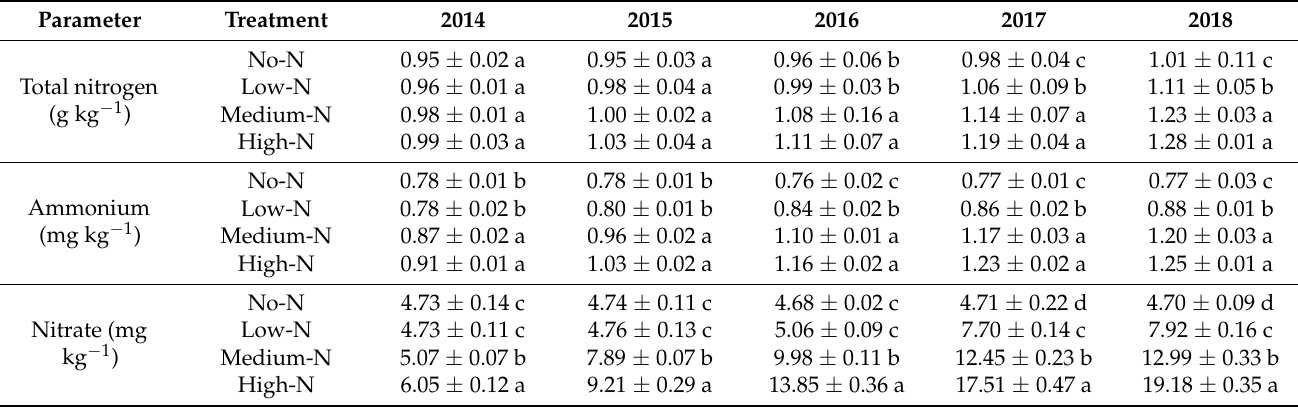
Table 3. Effects of inorganic nitrogen enrichment on total nitrogen, ammonium nitrogen (NH 4+ -N), and nitrate nitrogen (NO 3 − -N) from 2014 to 2018.